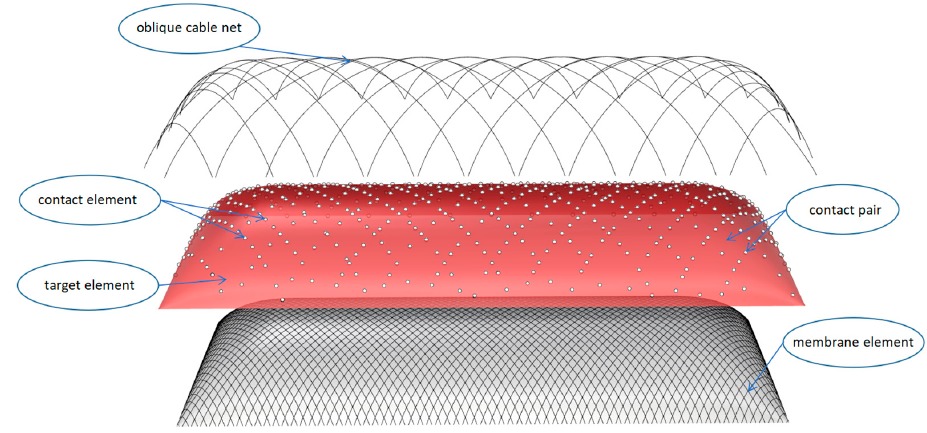
Figure 3. Three-dimensional layered display of contact model with an oblique cable net.